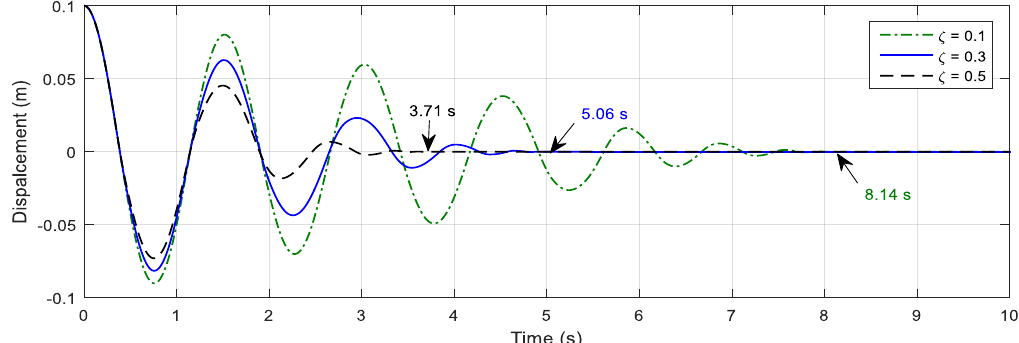
Figure 3. Transient responses of the superstructure according to change of 𝑘 𝑀⁄ in case of 𝜍 𝒓 = 0 .